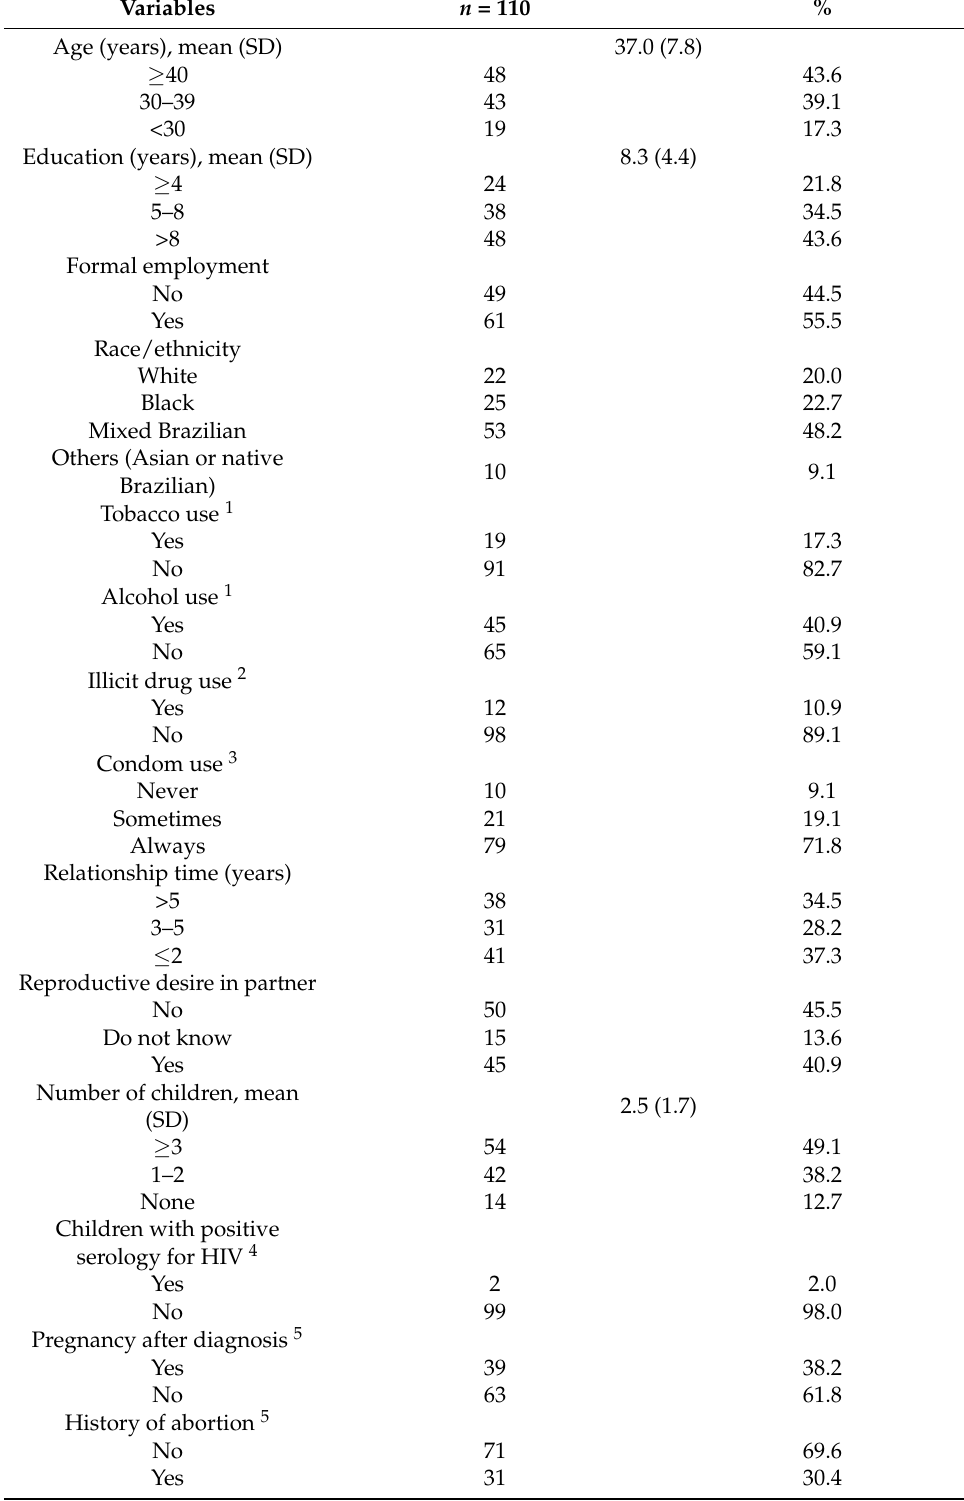
Table 1. Characteristics of women living with HIV/AIDS with serodiscordant partners, Goi á s State,